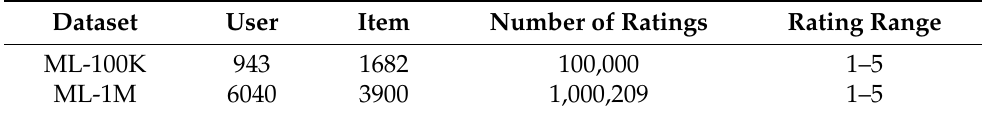
Table 1. The information of the